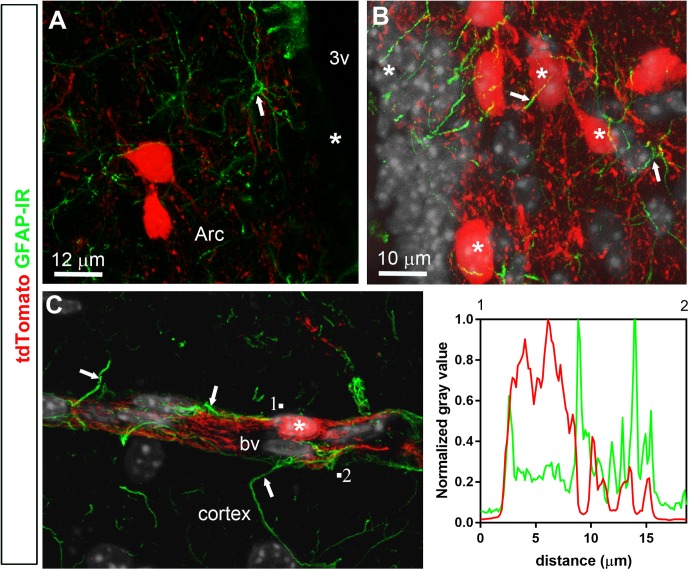
Distribution of GFAP immunoreactivity relative to tdTomato-labeled cells. (A,B) GFAP immunoreactivity was evident in astrocytic processes approaching very closely tdTomato cells (asterisks) in the hypothalamus and cortex, among other representative brain regions. However, GFAP never colocalized with tdTomato fluorescence and, furthermore, tdTomato-labeled cells never resembled astrocytes. (C) Representative tdTomato cell in a perivascular position is seen in close apposition to GFAP processes (white arrows). However, intensity plot profiles (between 1 and 2) demonstrated that GFAP did not coincide well with tdTomato. DAPI was converted to gray. Scale bar in (B) applies to (C). Arc, arcuate nucleus; bv, blood vessel.